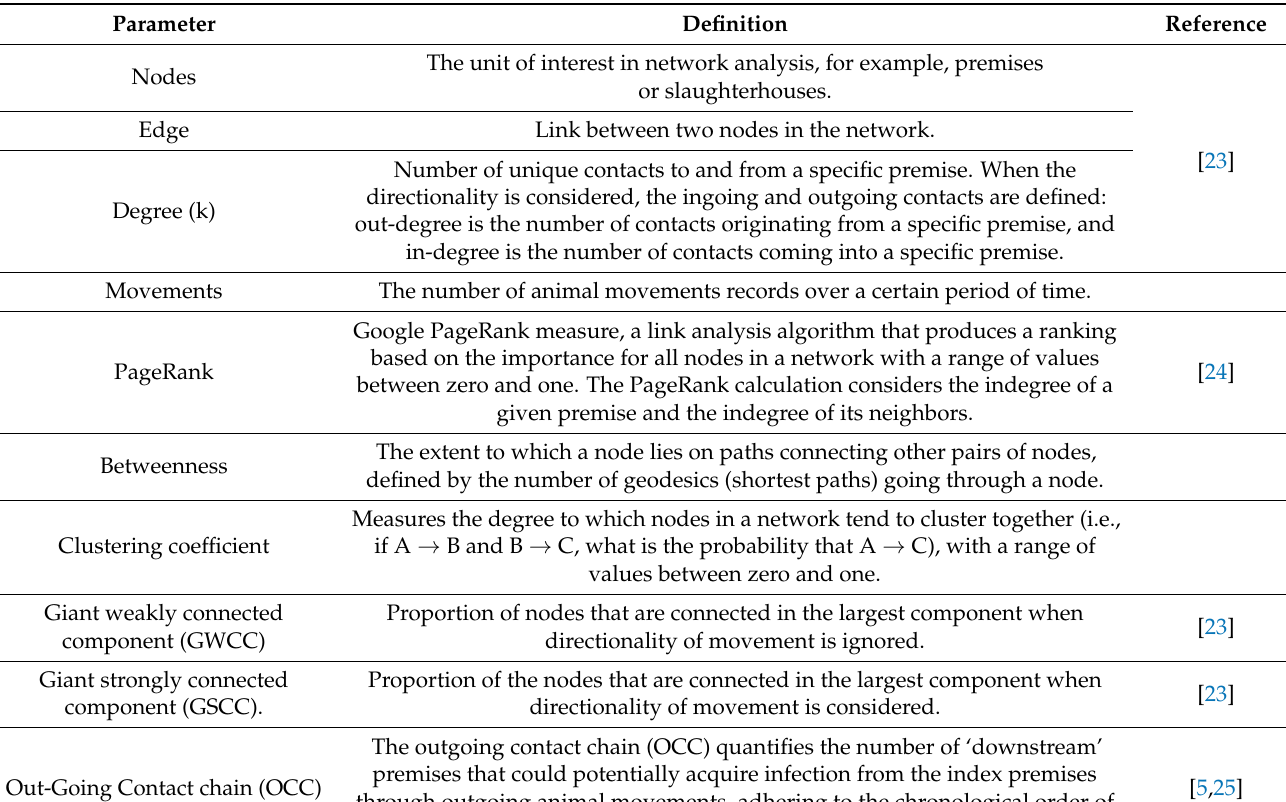
Table 1. Description of network analysis terminology and